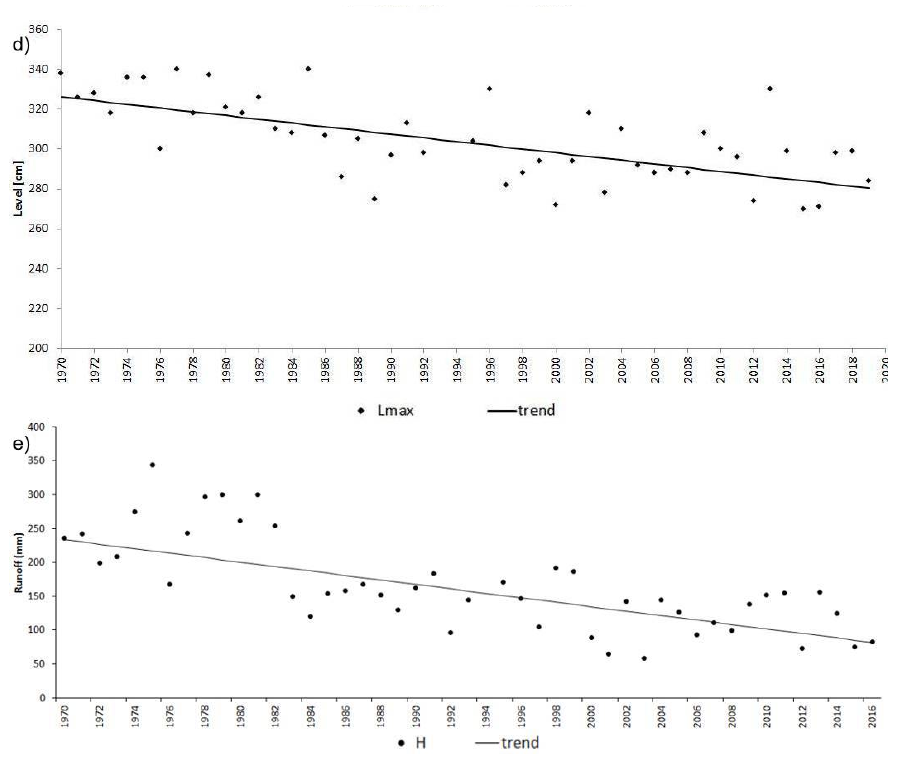
Figure 4. Water level characteristics in the Lebiedzianka River from 1970 to 2019: ( a ) frequency distribution of the daily values of water levels, ( b ) boxplot of daily water levels, ( c ) number of days with high water per year, ( d ) maximum annual water level (Lmax), ( e ) catchment runoff (H) from 1970 to 2016. (The equations for trend lines are summarized in Table 1.)